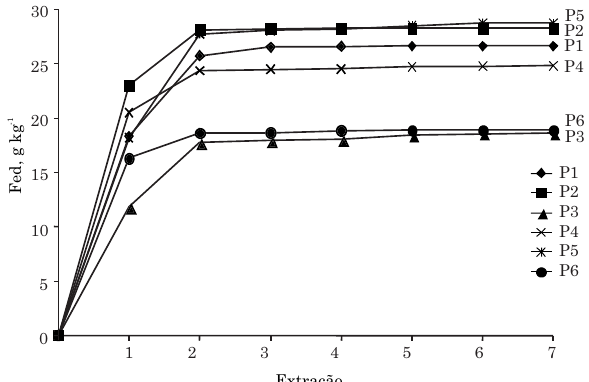
Figura 1. Teores acumulados de ferro, referentes a sete extrações sucessivas com DCB, na fração argila dos horizontes Bw dos